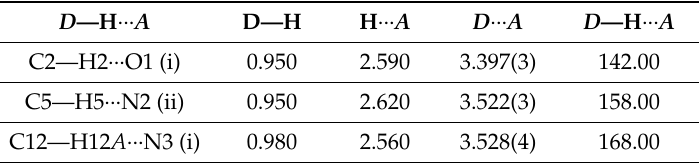
Figure 4. Crystal packing of the target compound. Table 2. Hydrogen bonding of the target compound.